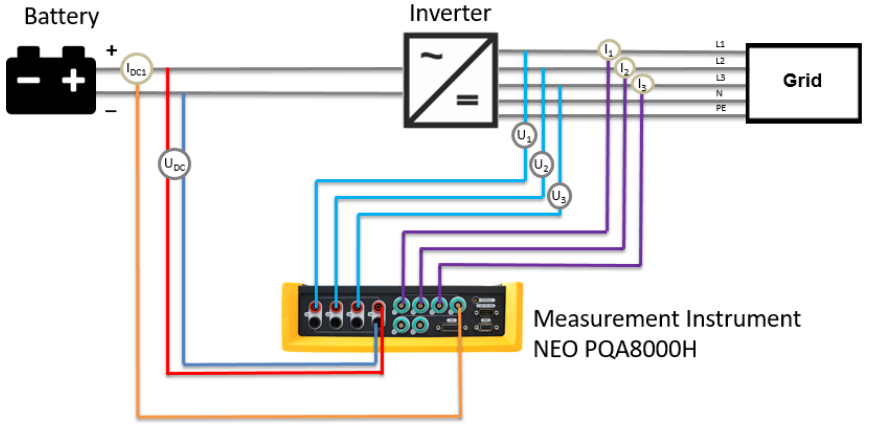
Figure 3. Measurement setup using the NEO PQA8000H Power Quality Analyzer.